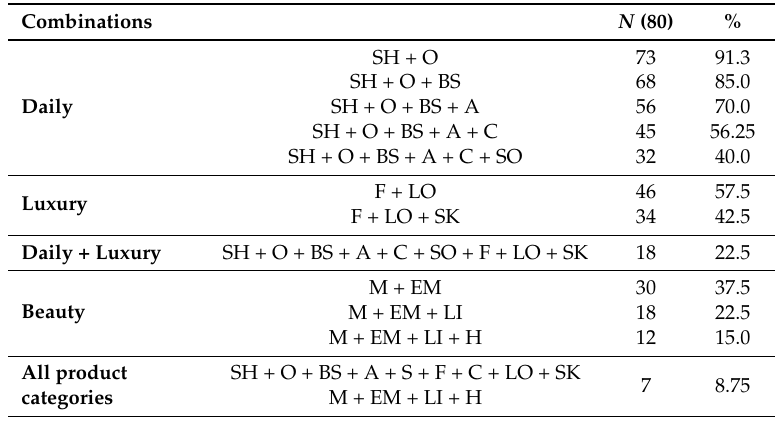
Table 3. Co-use combinations by Cluster. Co-use combinations are shown for clusters identified in Figure 8.